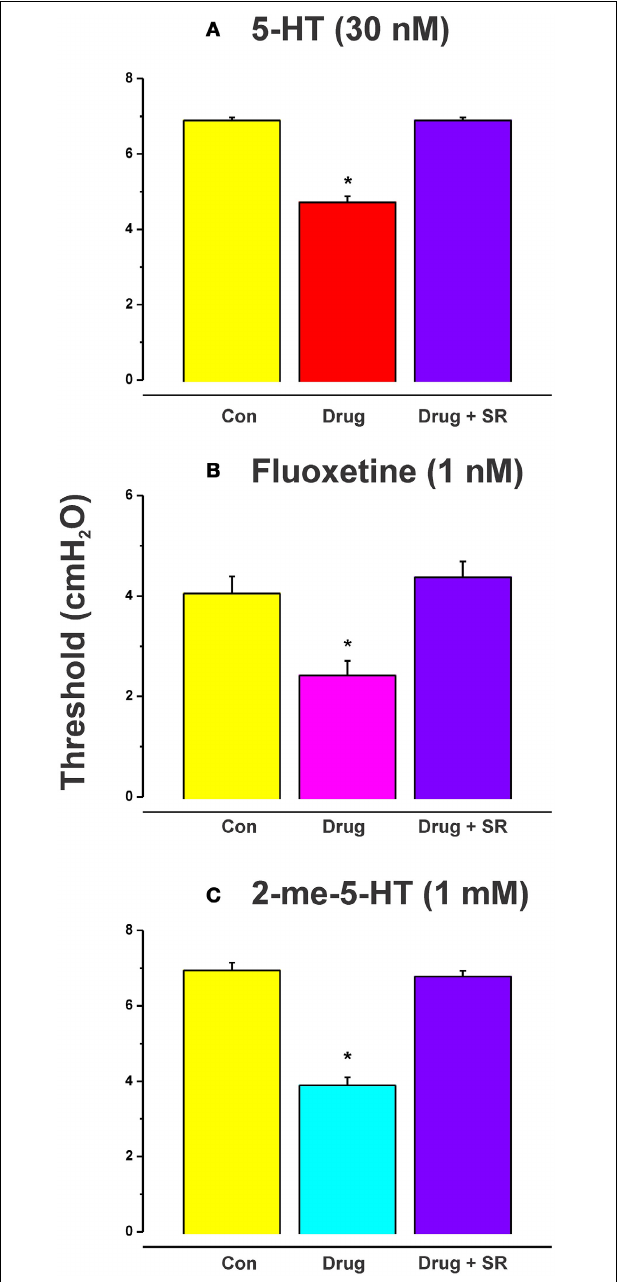
FIGURE 3 | Effects of blockade of NK 3 tachykinin receptors on the reduction in threshold for initiation of propulsion evoked by serotonin agonists. The specific NK 3 tachykinin receptor antagonist SR 142801 (SR; 100nM) blocked the reduction in threshold for initiation of propulsive contractions in the ileum induced by 5-HT (A) , fluoxetine (B) , and 2-me-5-HT (C) . ∗ Indicates significantly different from control with P < 0 . 05 in all cases.